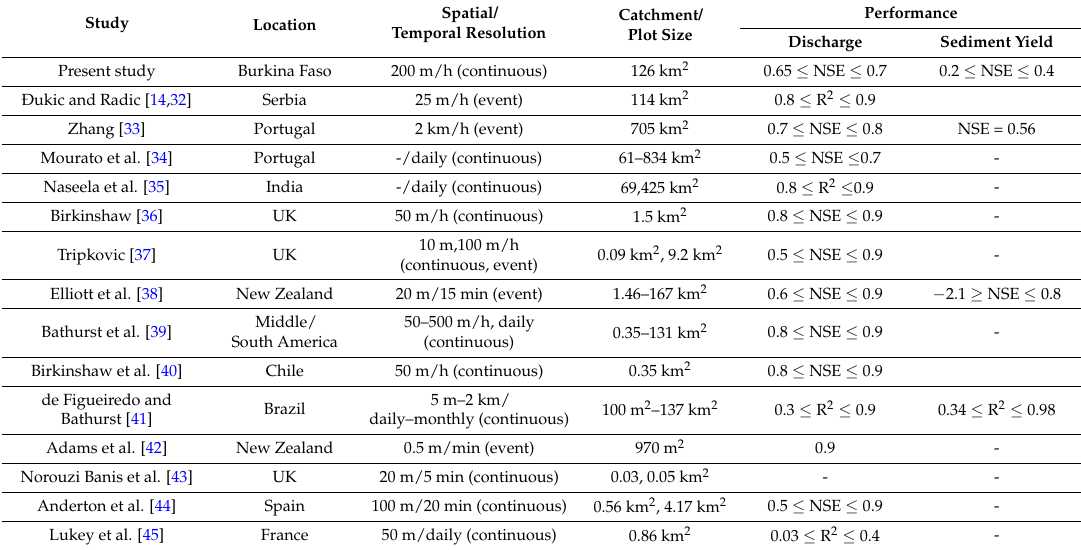
Table 2. Selected studies using SHETRAN for water flow and/or sediment flow